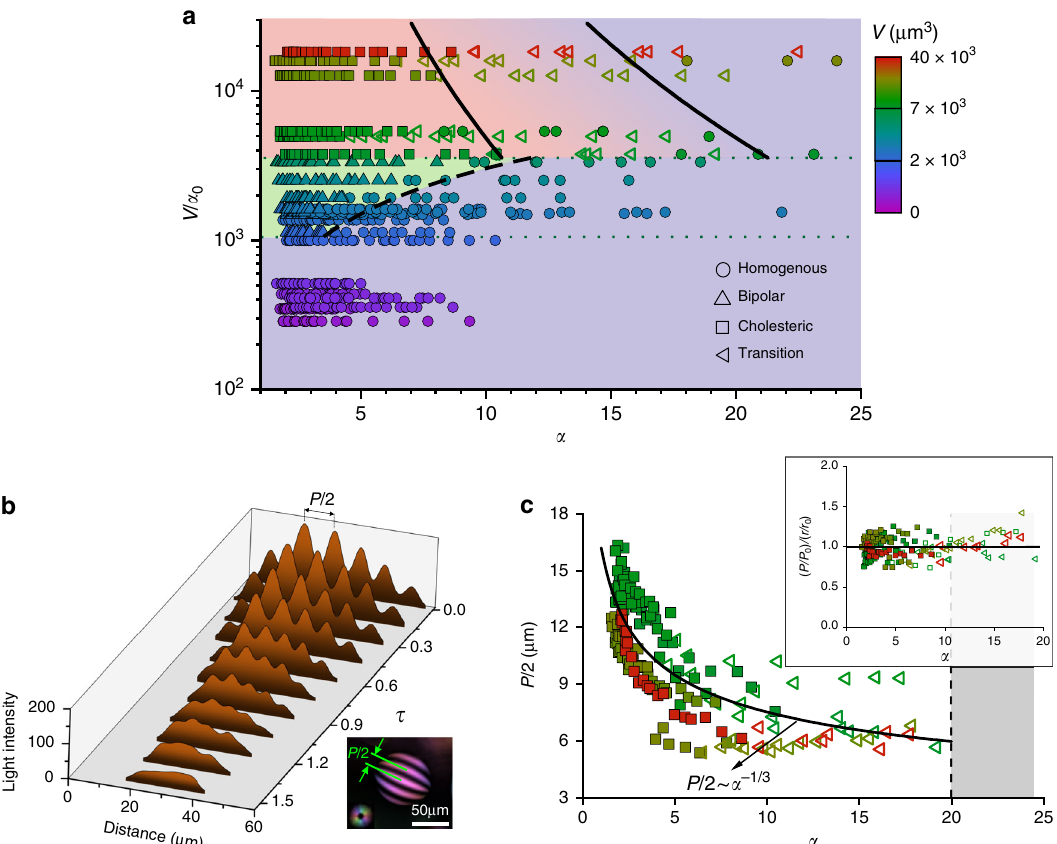
Fig. 4 Phase diagram of nematic – cholesteric tactoids at different elongation ratios. Filled circle, triangle, and square symbols denote homogenous, bipolar, and cholesteric tactoids. The empty symbols correspond to the transition regime of cholesteric to homogenous tactoids. a The developed theory (cid:6) (cid:7) 3 and cholesteric to homogenous (solid lines), that is, predicts the transition for the bipolar to homogenous (dashed line), that is, α ¼ cV γω K (cid:4) (cid:5) 3 = 5 α ¼ cV (cid:2) 1 = 5 γω . The term α 0 denotes the initial aspect ratio of the tactoids. The constant c value is 0.8 for bipolar to homogenous transition; and for K 2 q 2 1 cholesteric to homogenous tactoids, the c value is 14.5 for the lower and 29.0 for the upper boundary of the transition region. b Evaluation of the cholesteric pitch under constant extension rate of 0.013 s − 1 showing both decrease of cholesteric pitch and order – order transition of the cholesteric tactoids. c Change in cholesteric pitch as a function of aspect ratio that scales as P /2 ~ α − 1/3 . The inset shows that ratio of P / r , for a given cholesteric tactoid, remains essentially constant at different elongation